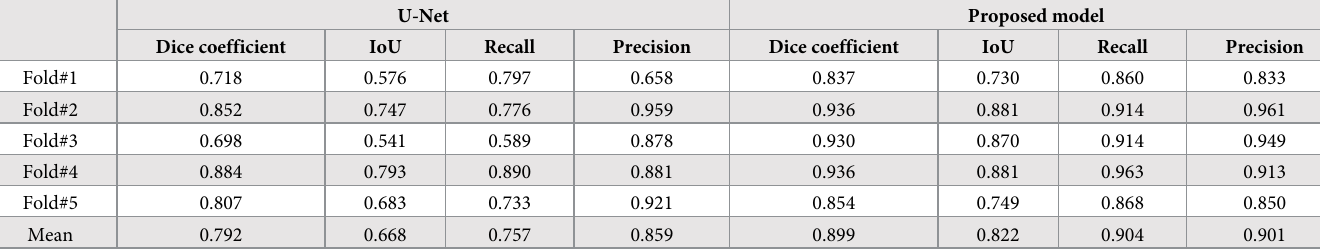
Table 1. Results of five-fold cross-validation for U-Net and the proposed model in the test dataset.